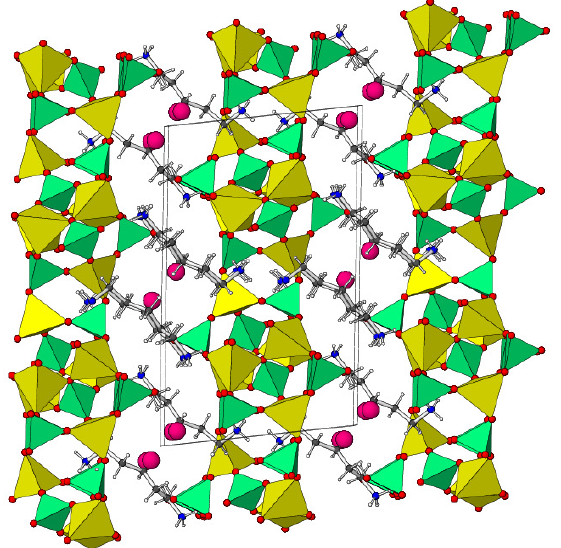
Figure 6. The packing of 2 viewed down [010] showing the (100) inorganic layers sandwiching the organic cations and water molecules (pink spheres); other polyhedron/atom colors as in Figures 2 and